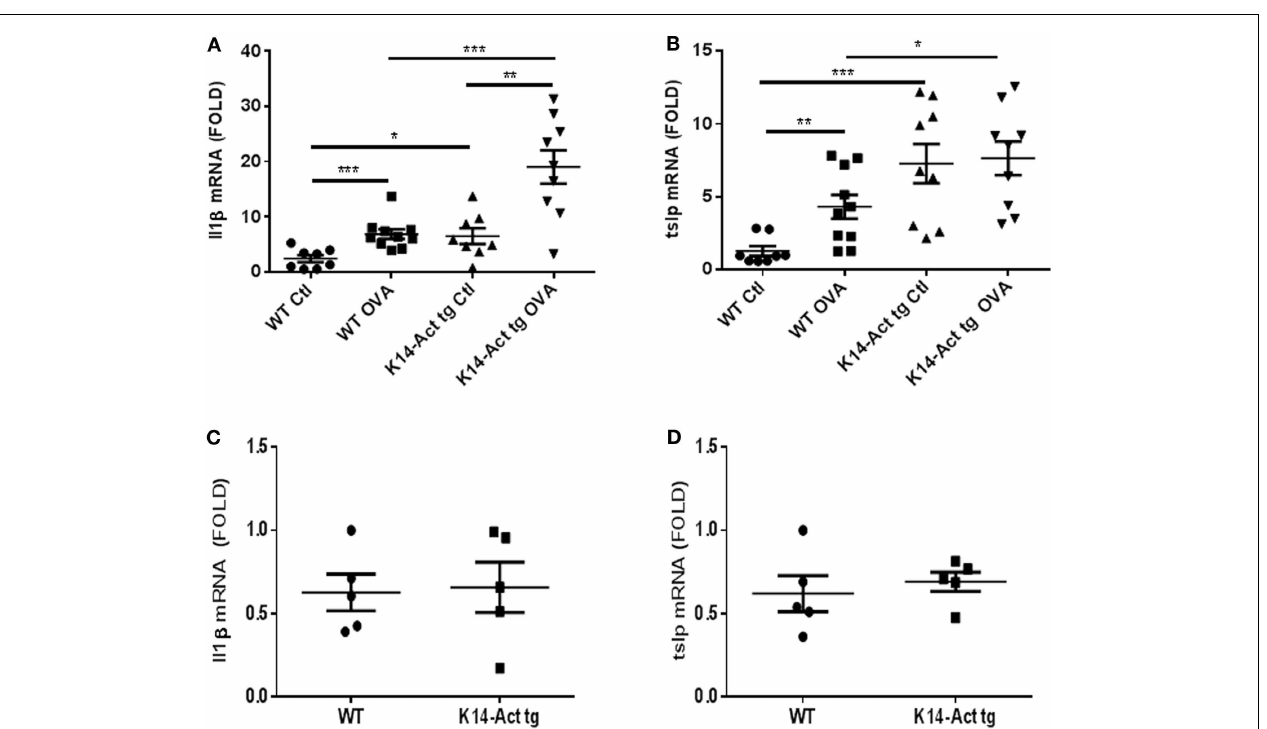
the hprt house-keeping gene.The experiment was realized in groups of five mice for the untreated and 8–10 mice for the vehicle- or OVA-treated mice. Results are presented in a scatter graph and mean values ± SEM are shown. Statistical differences were calculated with the Mann–Whitney U -test ( p < 0.05*, p < 0.01**, and p <